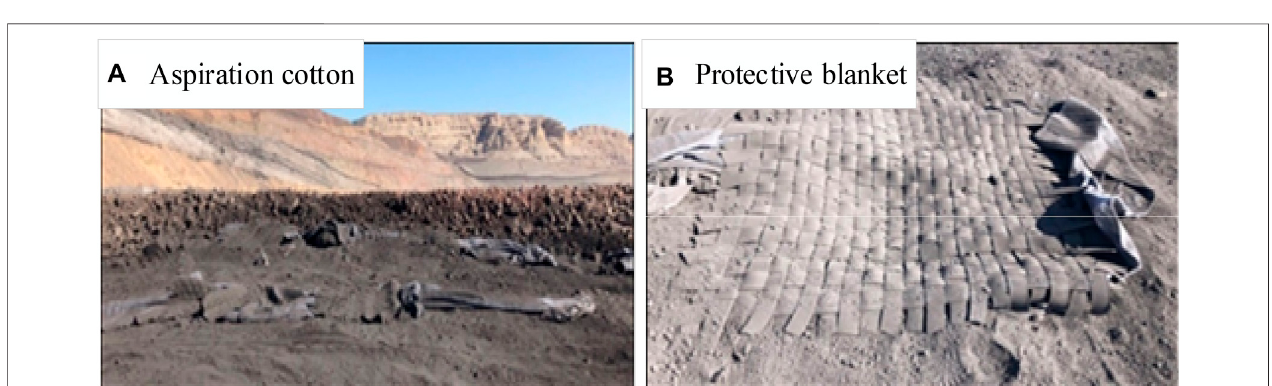
Frontiers in Earth Science |